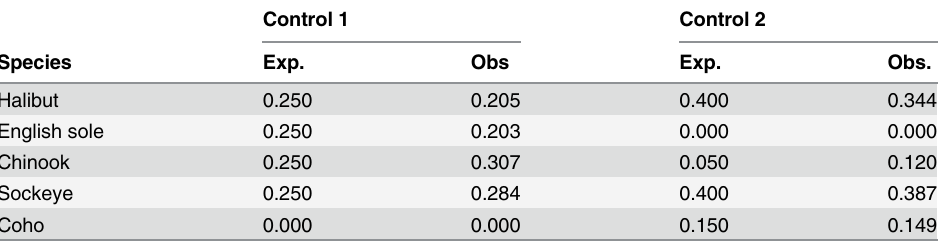
Table 3. Expected and observed proportions of sequences in the experimental